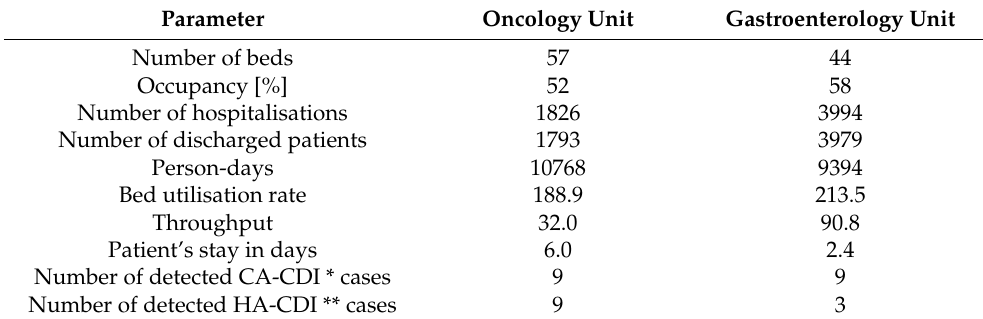
Table 1. Characteristics of the Paediatric Oncology Unit and Paediatric Gastroenterology Unit. Data reported in